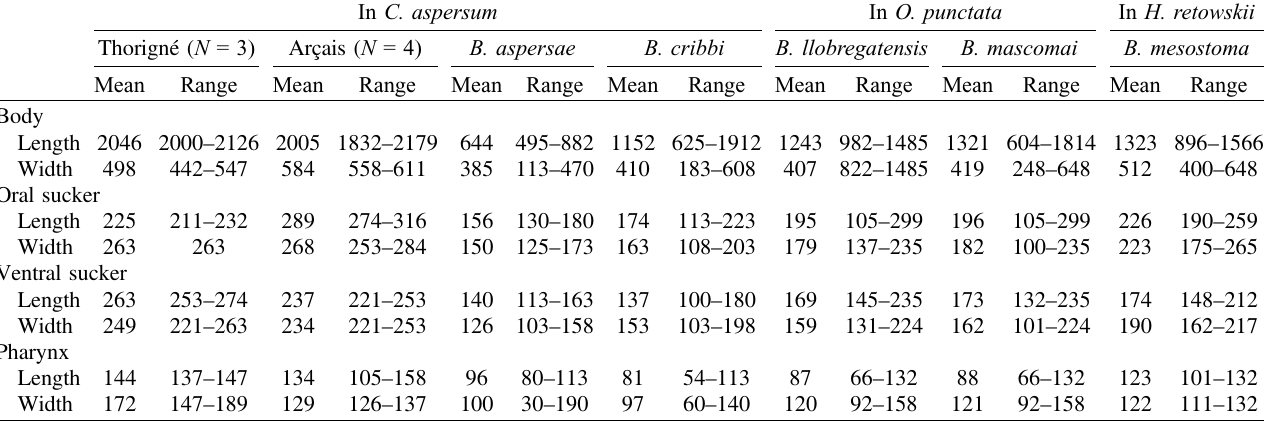
Table 5. Measurements (in l m) of Brachylaima metacercariae in Cornu aspersum from Thorigné-Fouillard ( N = 10) and Arçais ( N = 10), and comparison with the four Brachylaima species recorded in C. aspersum ( B. aspersae , B. cribbi, B. llobregatensis , and B. mascomai ) and with Brachylaima mesostoma . Measurements of B. aspersae and B. cribbi are reported from metacercariae found in C. aspersum [3, 53], those of B. llobregatensis and B. mascomai from the helicid Otala punctata [18, 42], and those of B. mesostoma from the hygromiid Helicopsis retowskii